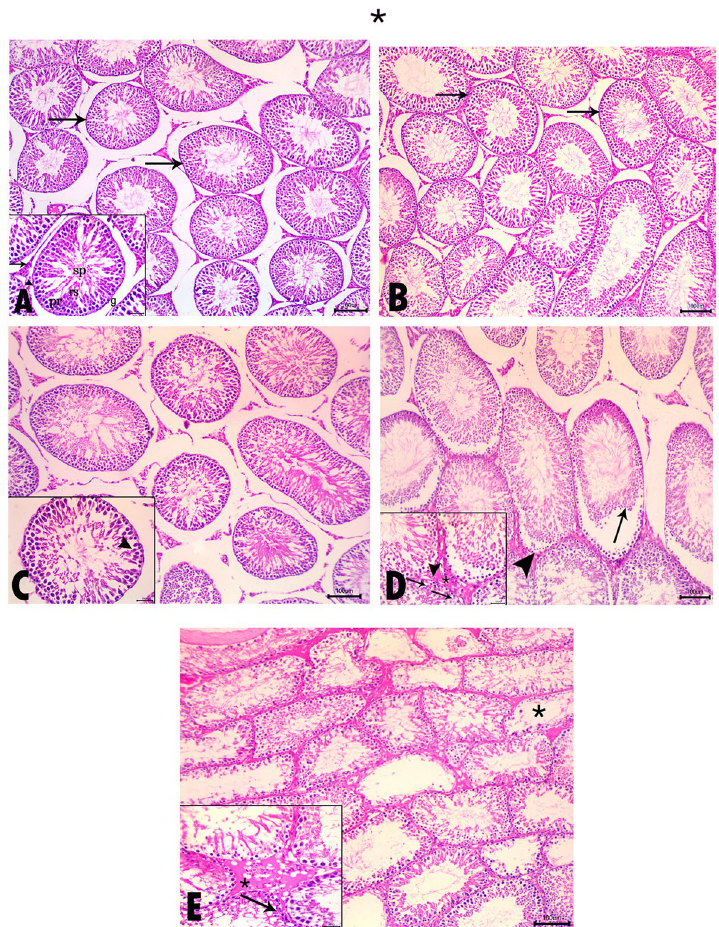
Fig. 15 Photomicrographs of sections in the testes stained with H&E ( 100, inset 400). A and B Negative and positive control groups show × × normal seminiferous tubules (arrows) lined with stratified epithelium and separated by loose interstitial connective tissue. Inset ; primary spermatocytes (pr), spermatogonia (g), round spermatids (rs), and sperms (sp). Sertoli cells (arrowhead) and Leydig cells (arrow). C Acute treated group showing seminiferous tubules with wide interstitial space. Inset ; show reduction in the germinal epithelium (arrowhead). D Chronic treated group reveals distortion of seminiferous tubules, sloughing of germ cells nuclei, and exfoliation into the tubular lumen (arrow). Tubular basement membrane separation (arrowhead) is also seen. Inset ; show vacuolation (arrows) with disorganized seminiferous epithelium. Congested blood vessels (arrowhead) and interstitium deposition by an extremely acidophilic material (asterisk). E Chronic withdrawal group shows irregularity and distortion of seminiferous tubules. Some tubules show a decrease in the thickness of spermatogenic epithelium up to depletion with few or no sperms (asterisk). Inset ; revealed vacuolar degeneration (arrow) with dilated blood vessels and interstitium deposition by extremely acidophilic material